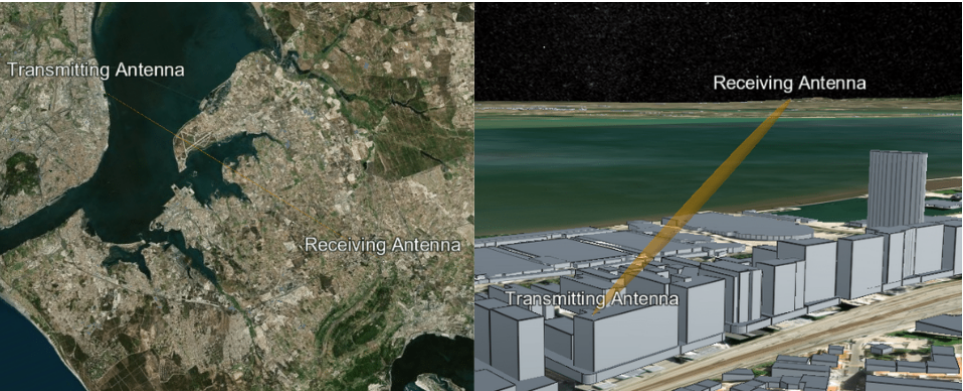
Figure 12. Simulated terrestrial project link.